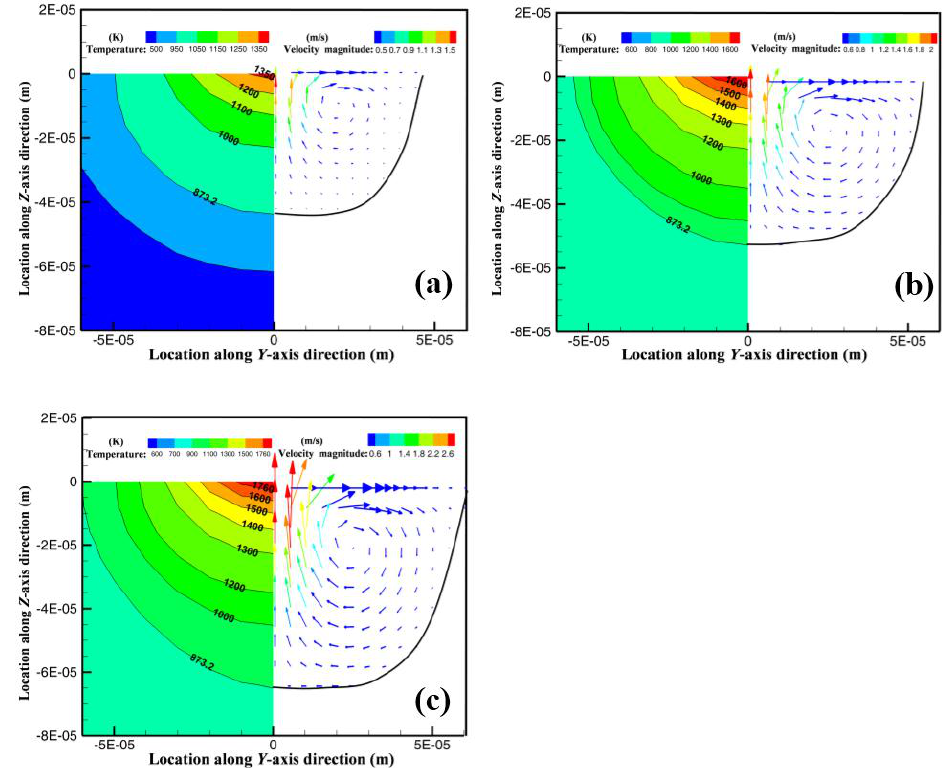
Figure 4. Simulated temperature counter and velocity fields within the melt pool in the cross-sectional view at different processing parameters: ( a ) 100 W, 400 mm/s; ( b ) 150 W, 400 mm/s; ( c ) 200W, 400